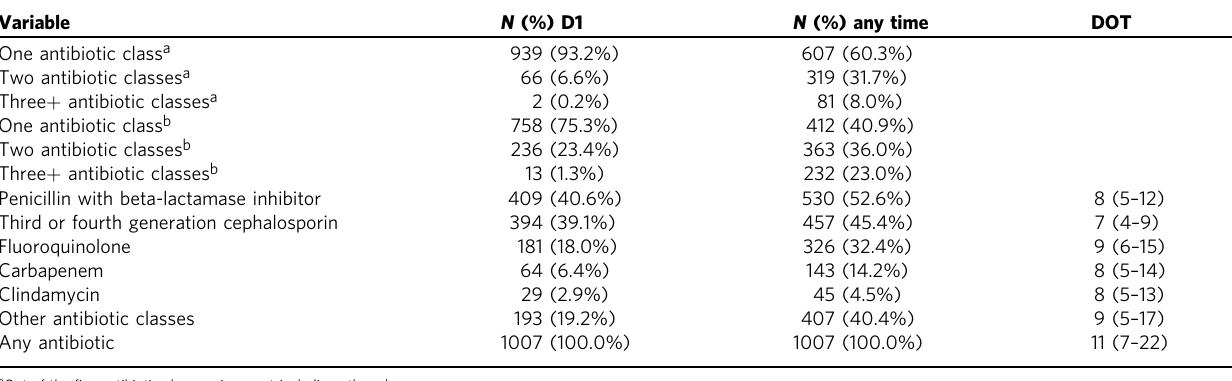
Table 2 Antibiotic treatment at baseline and during follow-up.